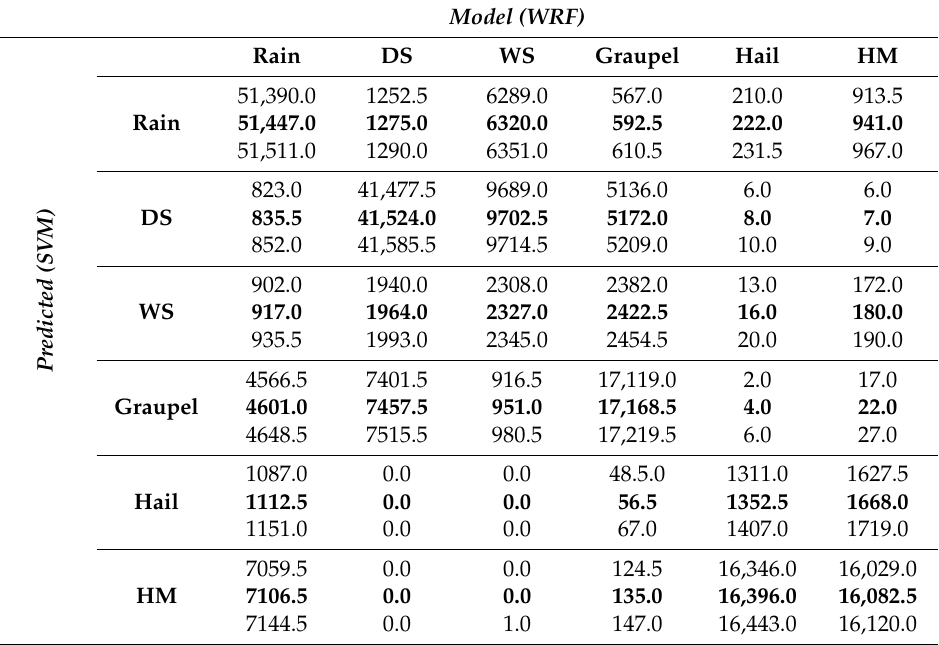
Table 2. Confusion matrix per class of the WRF scenario obtained by using 100 × 2 × 10 5 observations for each realization (infinite values are excluded in the CM). For each element, the CIs intervals (found using, the 10th, 50th , and 90th percentiles) are shown. Classifications matched by WRF and SVM are found along the diagonal and misclassifications are in the off-diagonal